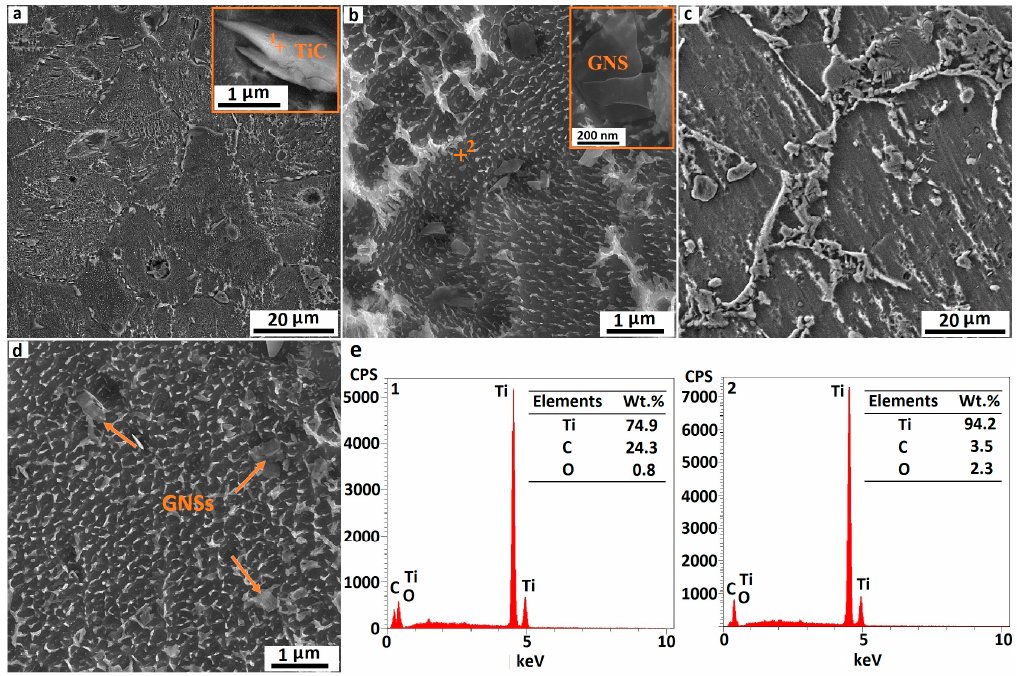
Figure 5. ( a , b ) SEM image of Ti/0.5GNSs composite sintered for 1 h, ( c , d ) SEM image of Ti/0.5GNSs composite sintered for 5 h, and ( e ) EDS analysis of selected points (images 1 and 2 represent the EDS analysis of points 1 and 2 in ( a,b ), respectively).